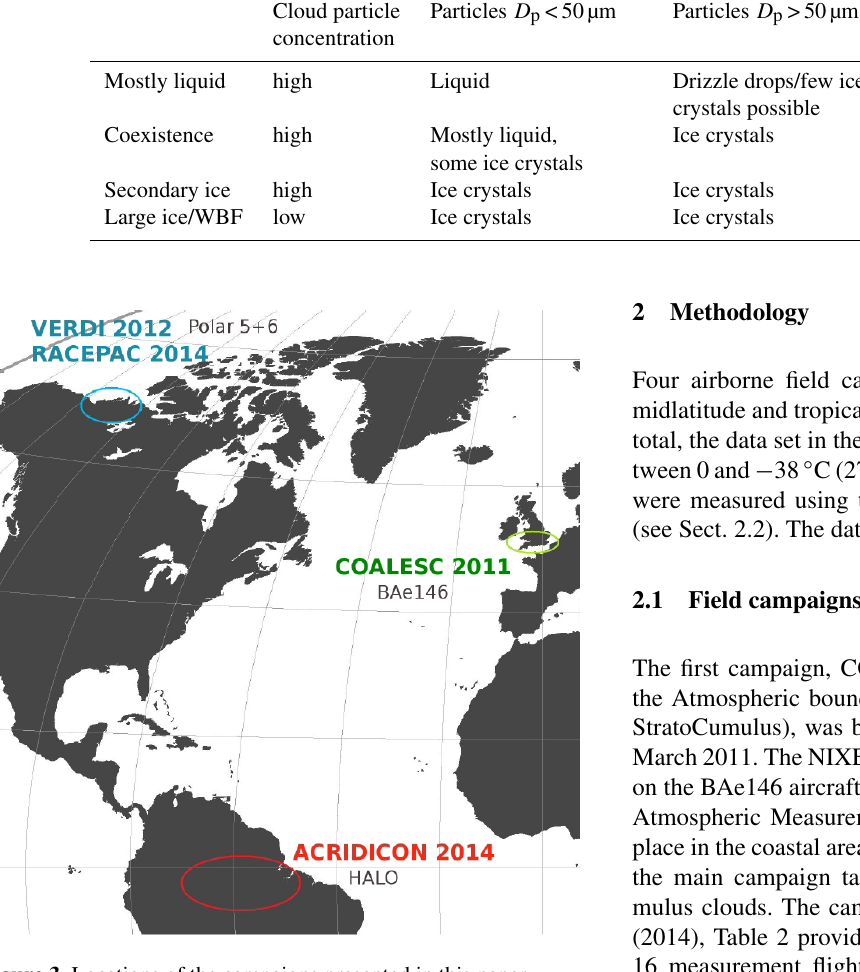
perature by performing a statistical analysis of the data ob- tained by the NIXE–CAPS (New Ice eXpEriment – Cloud and Aerosol Particle Spectrometer) cloud spectrometer with 1 Hz along the flight